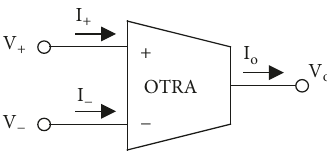
Figure 1: Circuit symbol of an